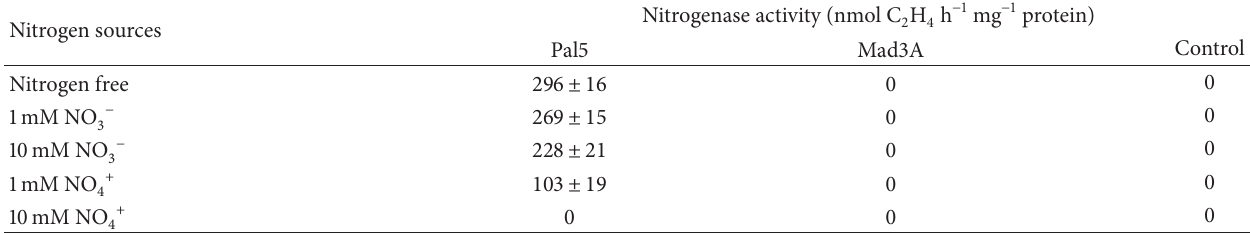
Table 3: Nitrogenase activity of Gluconacetobacter diazotrophicus strains Pal5 and Mad3A measured by acetylene reduction assay.